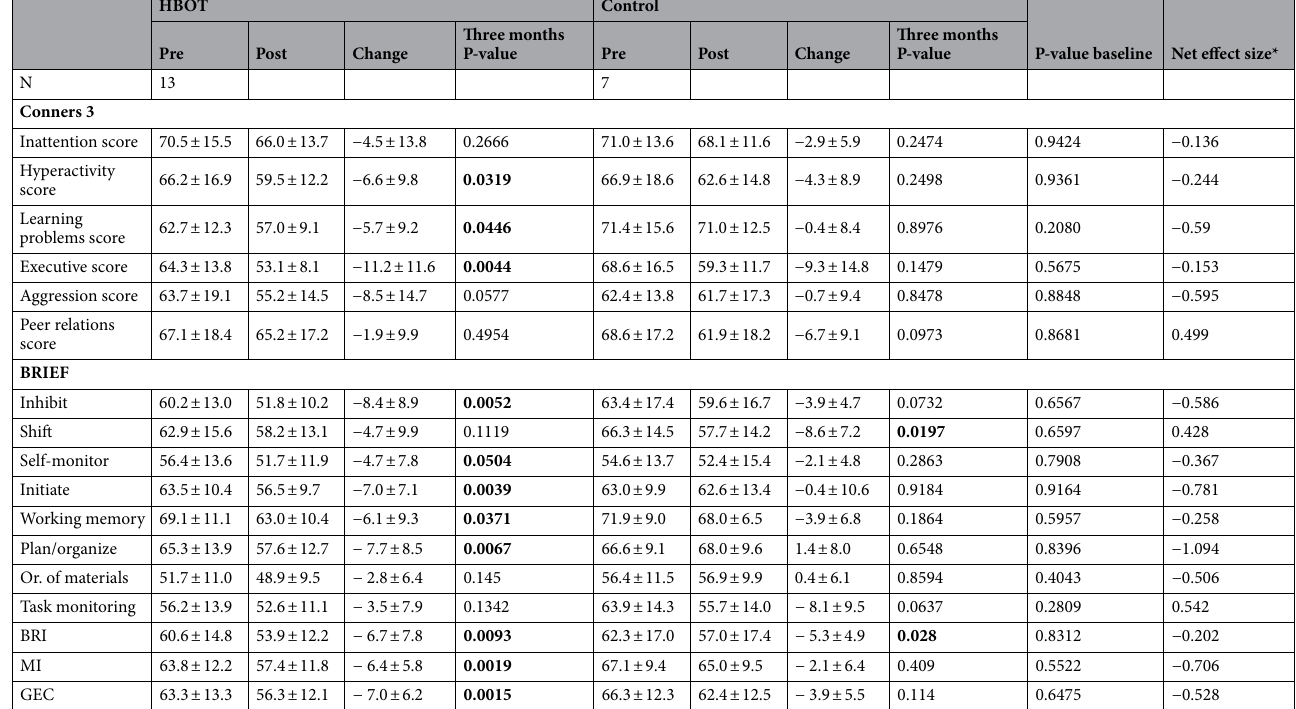
Table 4. Behavioral symptoms changes. Baseline comparison of p-values test the null hypothesis of equal means of the two groups at baseline using an unpaired t-test; three-month comparison of p-values test the null hypothesis of equal means of each group pre-post intervention (HBOT/sham respectively) using a paired t-test; bold, P < 0.05, net effect size is the subtraction of Cohen’s D effect size of the control group from the HBOT group Cohen’s D effect size. BRI behavioral regulation index, MI metacognition, GEC global executive composite.